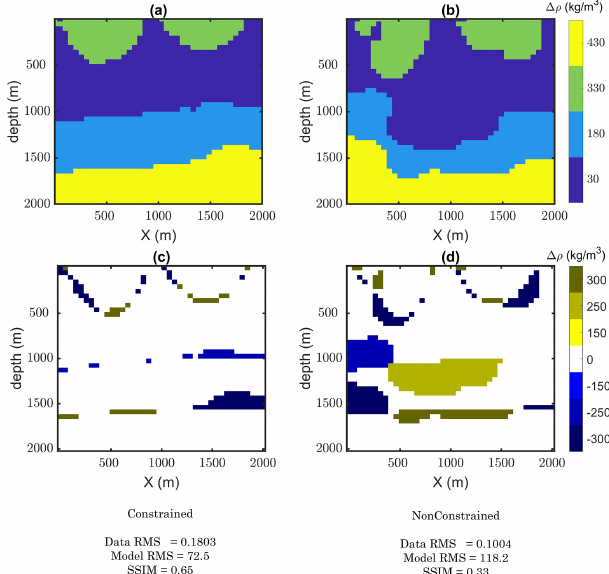
Figure 6. (a) Inverted model from the constrained inversion along seismic section. (b) Inverted model from the unconstrained inver- sion along the same section. (c) Difference between the model in (a) and the true model. (c) Difference between the model in (b) and the true model. Below these figures, the corresponding data and model RMSE and SSIM of two models are